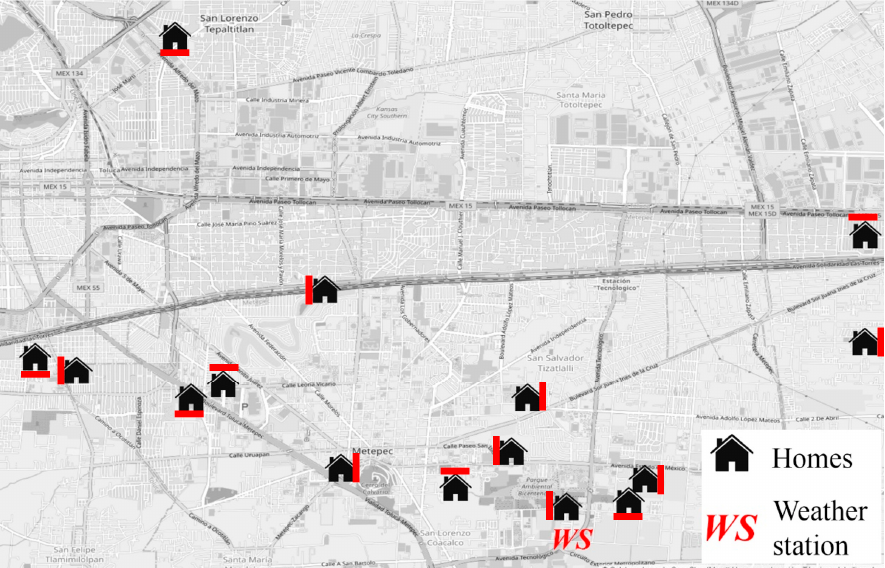
Figure 2. Location of the participating homes in Toluca and the weather station from which the external climatic data were obtained. Source of the background image was OpenStreetMap ® [47]. Source of the house icon was. The red line next to the house represents the orientation of the room in which the sensor was positioned.